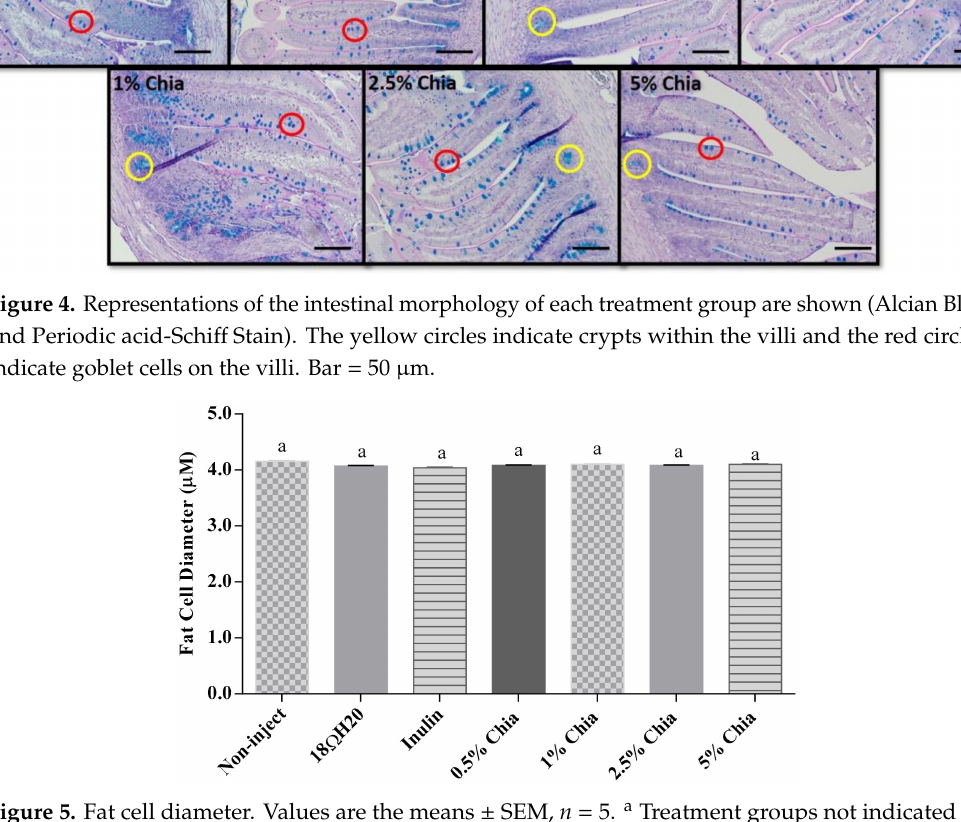
Figure 5. Fat cell diameter. Values are the means ± SEM, n = 5. a Treatment groups not indicated by the same letter are significantly di ff